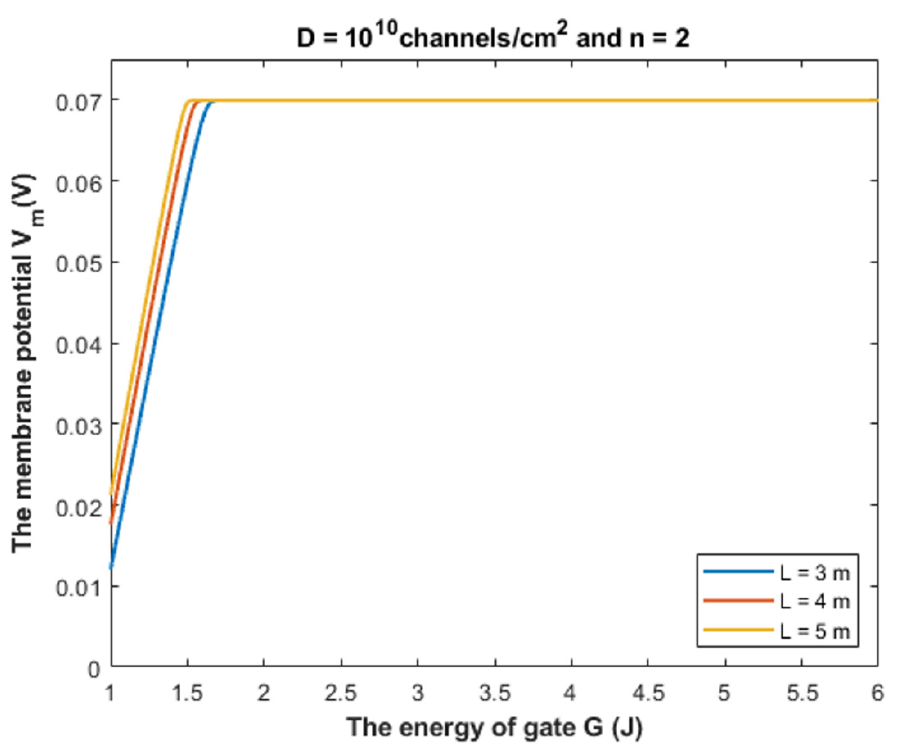
Figure 21. The figure represents the relationship between the energy of gate G and the membrane potential at gate length L values higher than 2 m to show its influence on the depolarization effect.